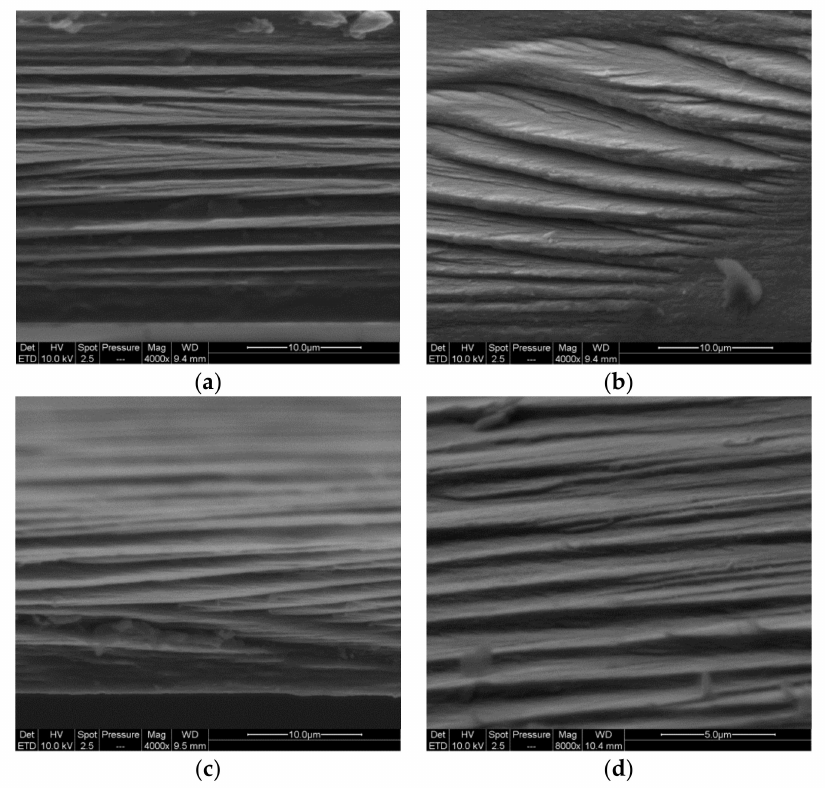
Figure 3. SEM images of the cross-section of films casted from suspensions H1 ( a ), H2 ( b ), H3 ( c ), and H4 ( d